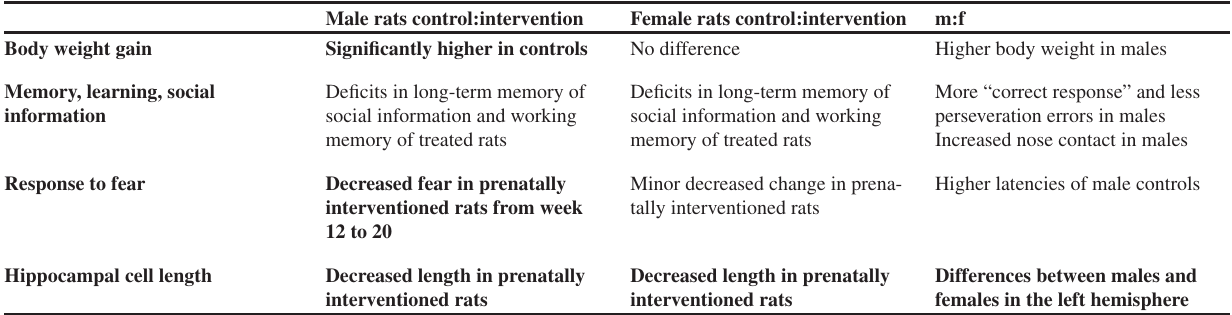
Table 2 - Effects of a prenatal intervention with kainic acid at day 18 of pregnancy on the offspring. We tested 12 male (m) and 14 female (f) controls, and 16 male and 15 female Fisher rats with prenatal intervention, from postnatal week 8 to week 24 Male rats control:intervention Female rats control:intervention m:f Body weight gain Significantly higher in controls No difference Higher body weight in males Memory, learning, social